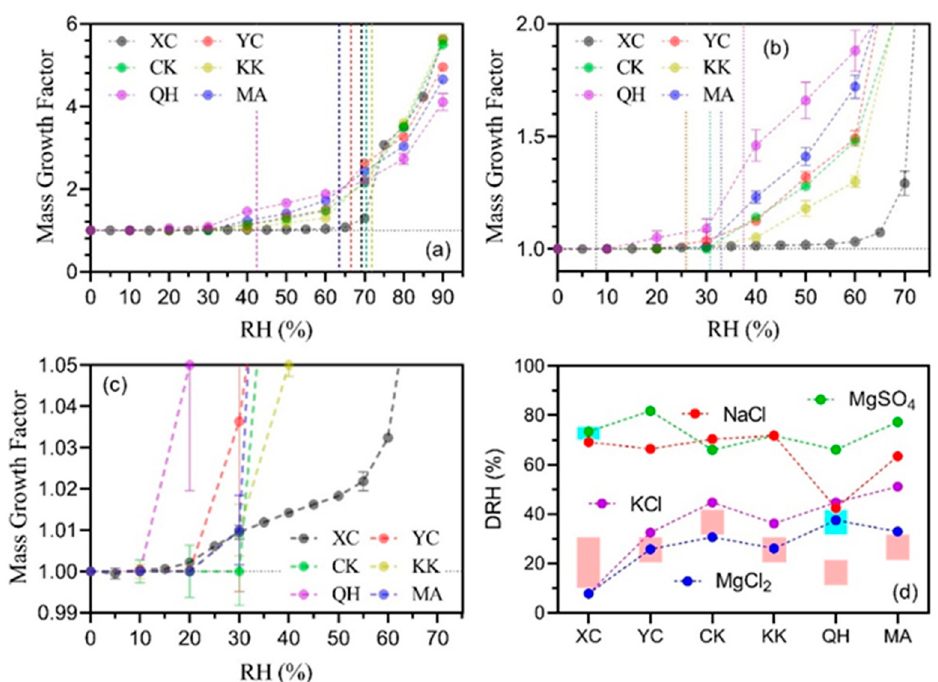
Figure 6. ( a – c ) Mass growth factor as a function of RH in different y-axis scales. ( d ) Calculated DRHs of four key salt components for the six samples. The red squares are the experimentally observed initial water uptakes and the blue squares are the experimentally observed major water uptakes.